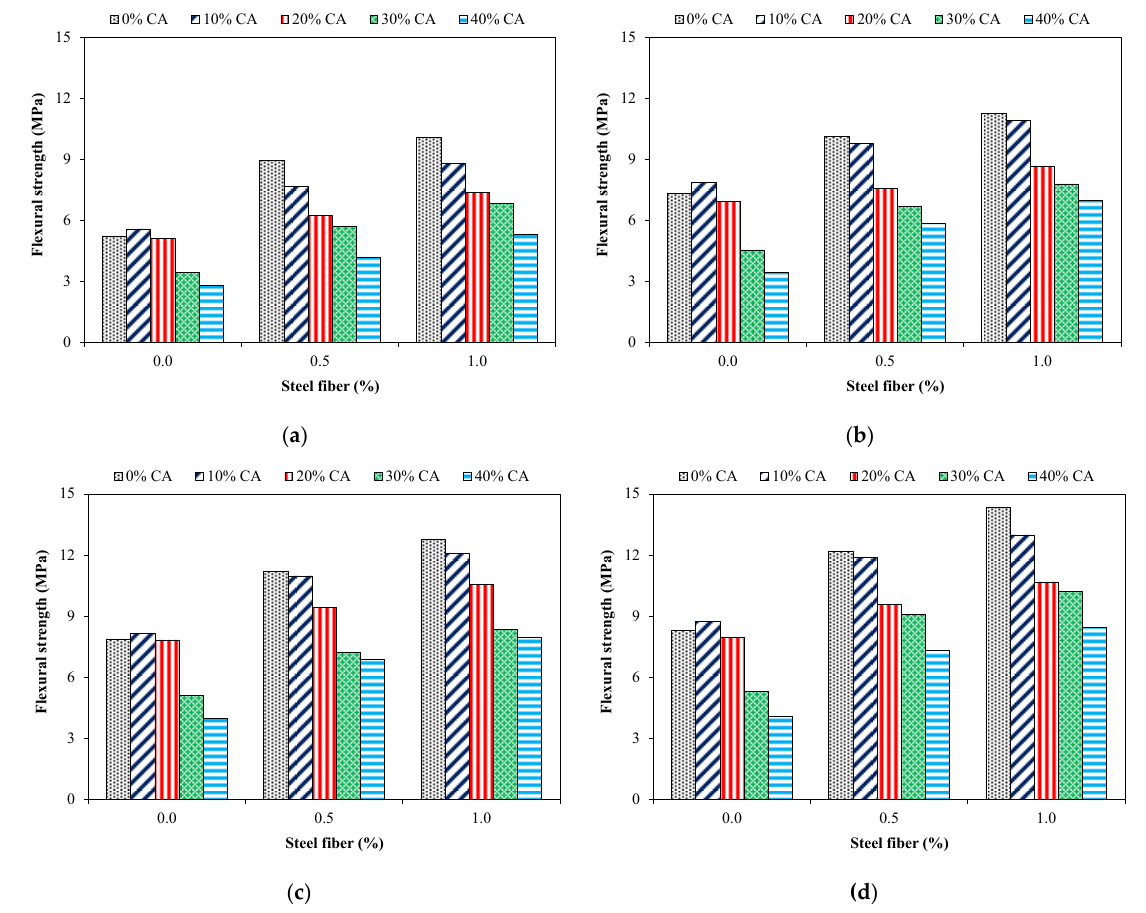
Figure 9. Flexural strength for specimens with steel fibers and CA dosages cured in normal water: ( a ) 14 days; ( b ) 28 days; ( c ) 56 days; ( d ) 90 days.